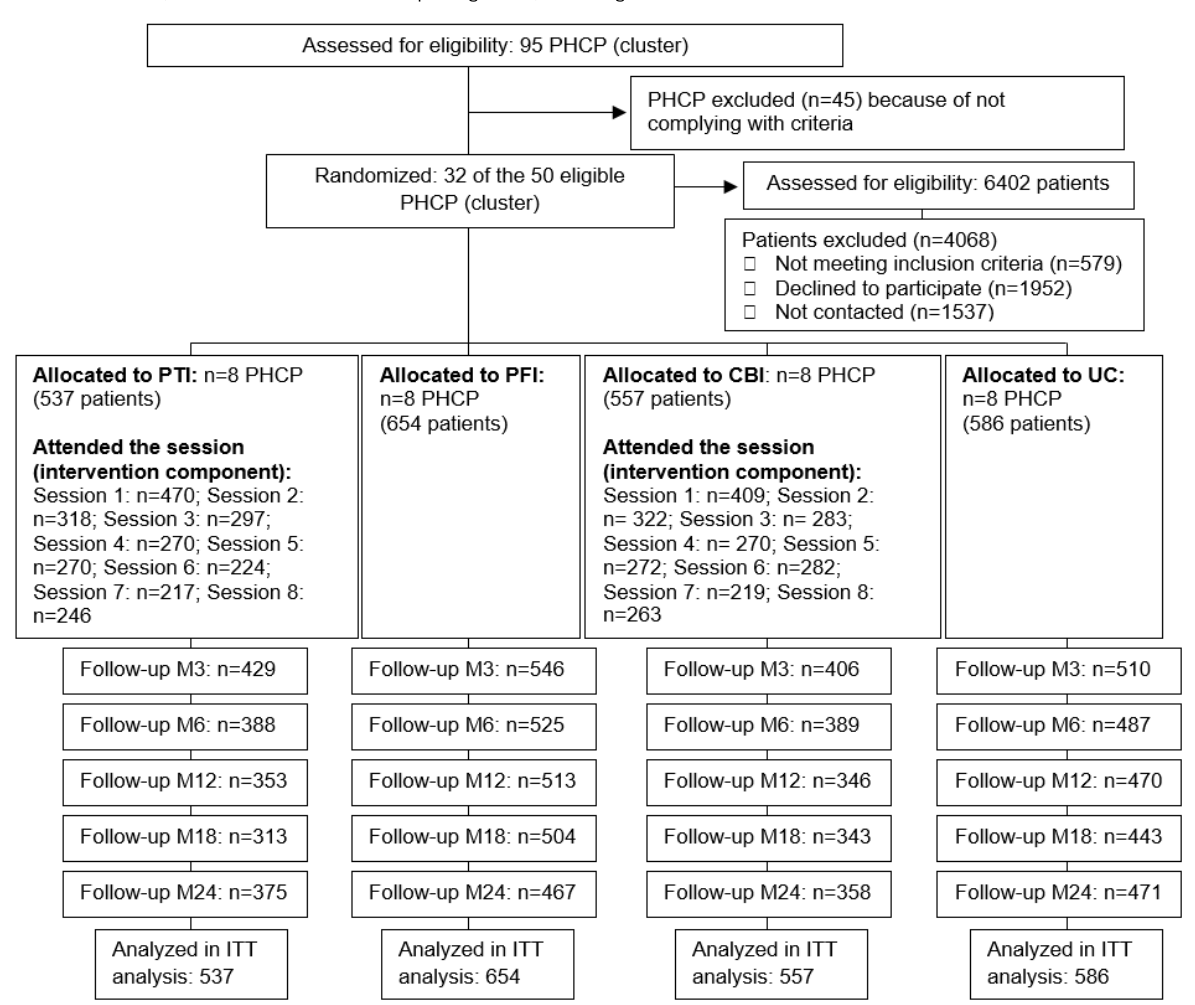
Figure 2. CONSORT (Consolidated Standards of Reporting Trials) flow